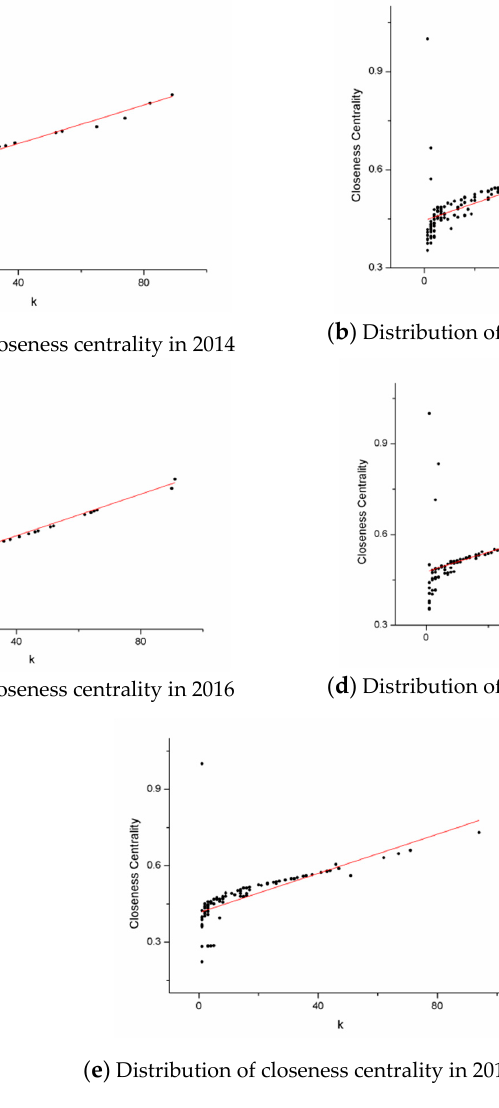
Figure 6. Distribution of closeness centrality during 2014–2018. Figure 5 contains five graphs, which are arranged by year as: ( a ) 2014, ( b ) 2015, ( c ) 2016, ( d ) 2017, ( e ) 2018.